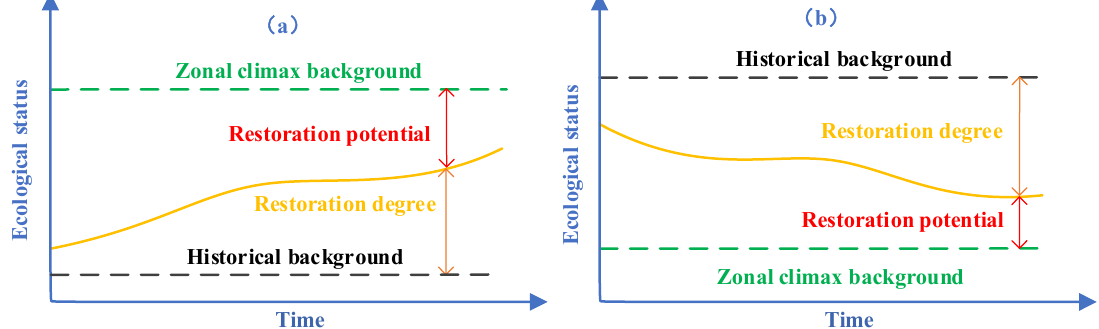
Figure 4. Schematic diagram of climax background, restoration degree, and restoration potential of ecological indicators in case of service increase ( a ) and service decrease ( b ).